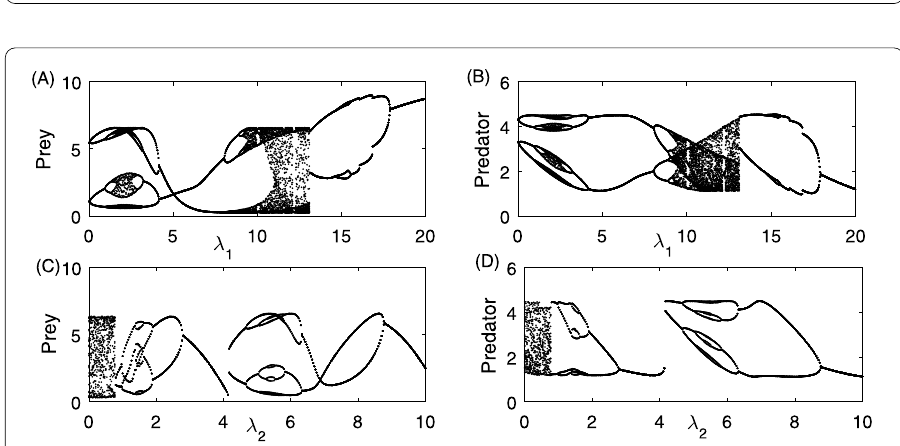
Figure 7 Bifurcation diagrams of model (17) with respect to bifurcation parameters λ 1 and λ 2 . Parameter values are: r = 2.79, k = 10, α = 1.2, c = 0.37, ω = 0.25, D = 0.59, δ = 0.69, h = 0.27, θ = 1.65, T = 21.( A – B ) λ 2 = 5.2;( C – D ) λ 1 =